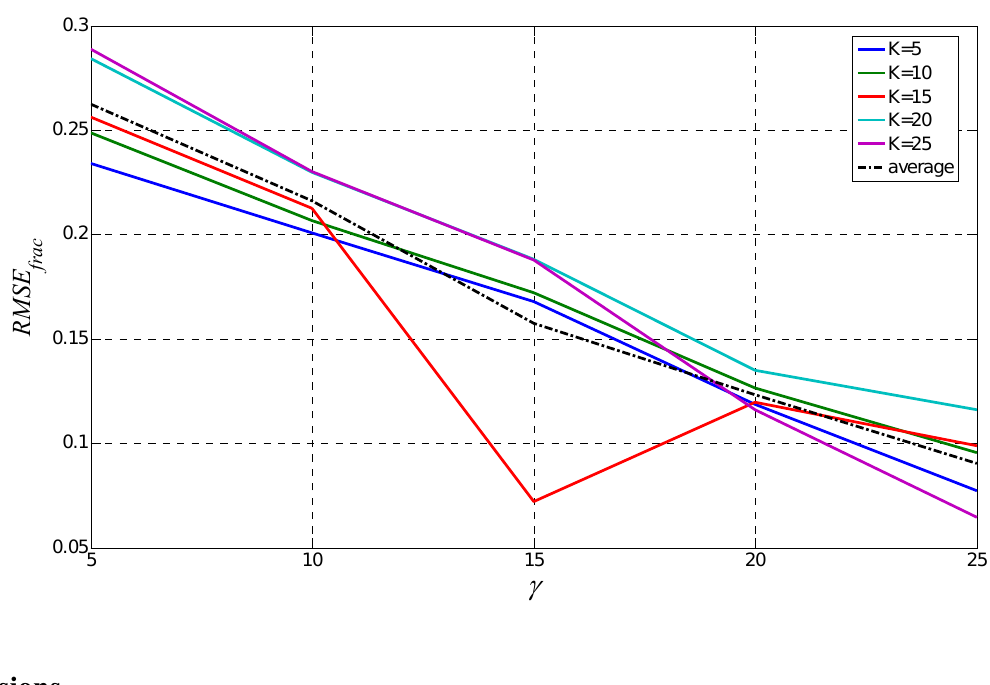
for the fractured text frac